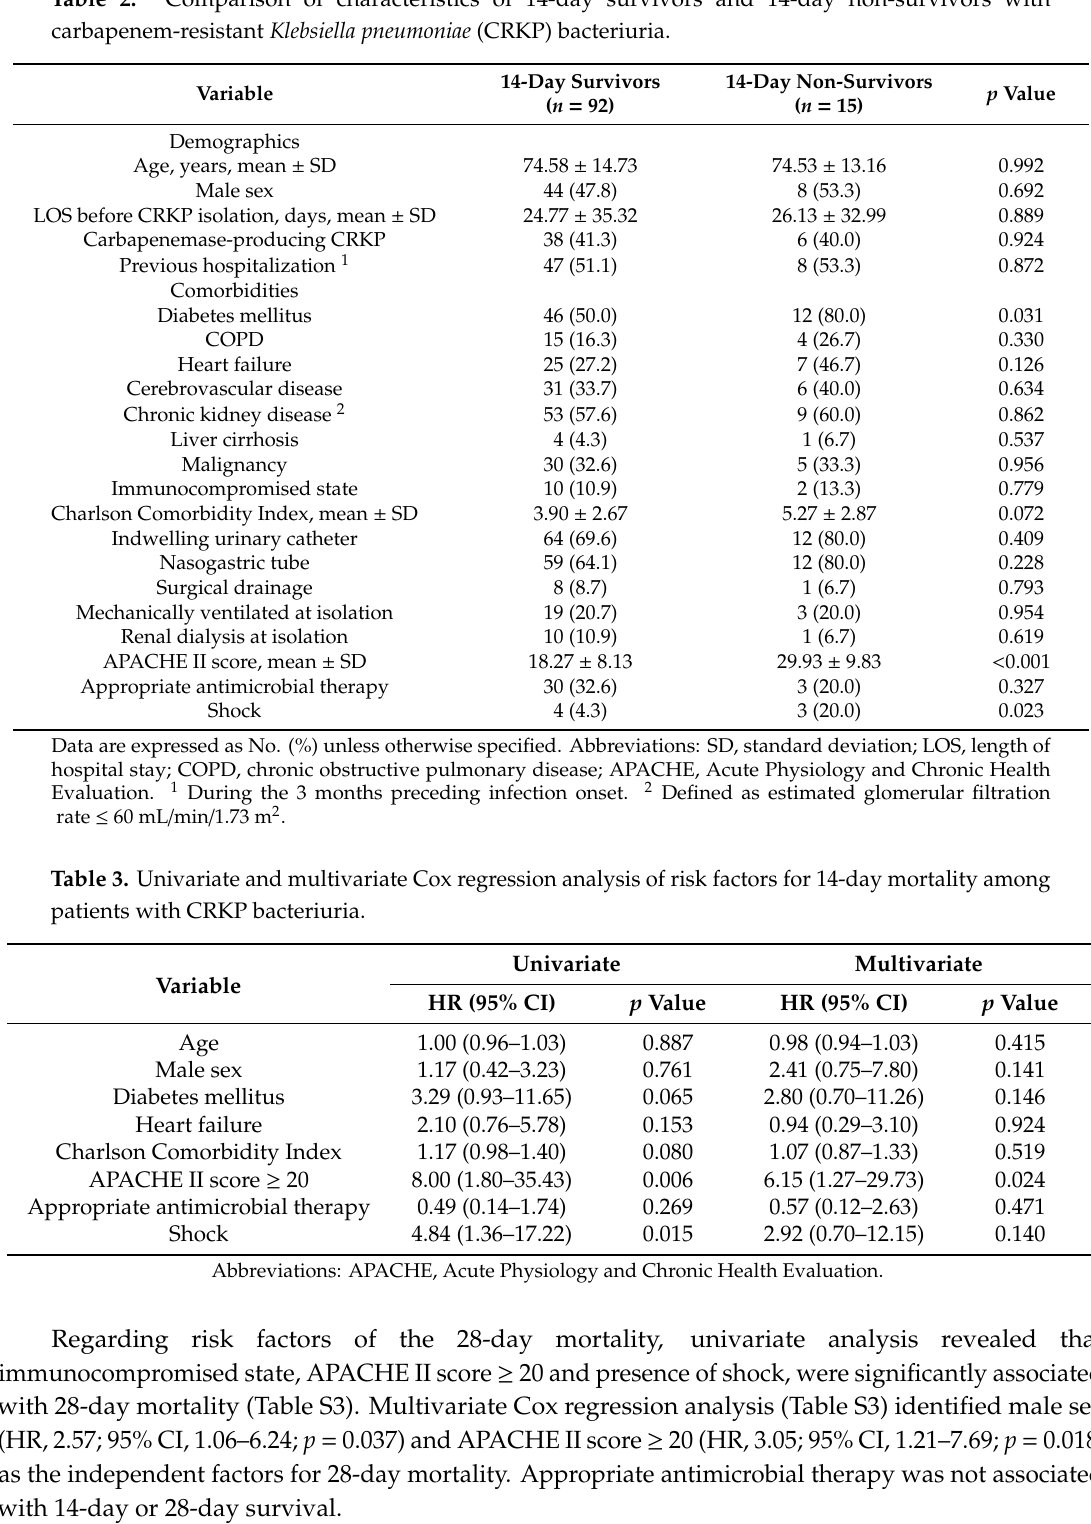
Table 2. Comparison of characteristics of 14-day survivors and 14-day non-survivors with carbapenem-resistant Klebsiella pneumoniae (CRKP) bacteriuria.